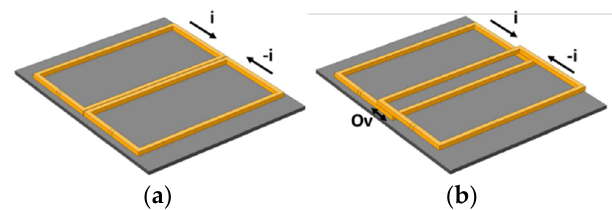
Figure 7. Detailed view of ( a ) DD coil, ( b ) BP structures.